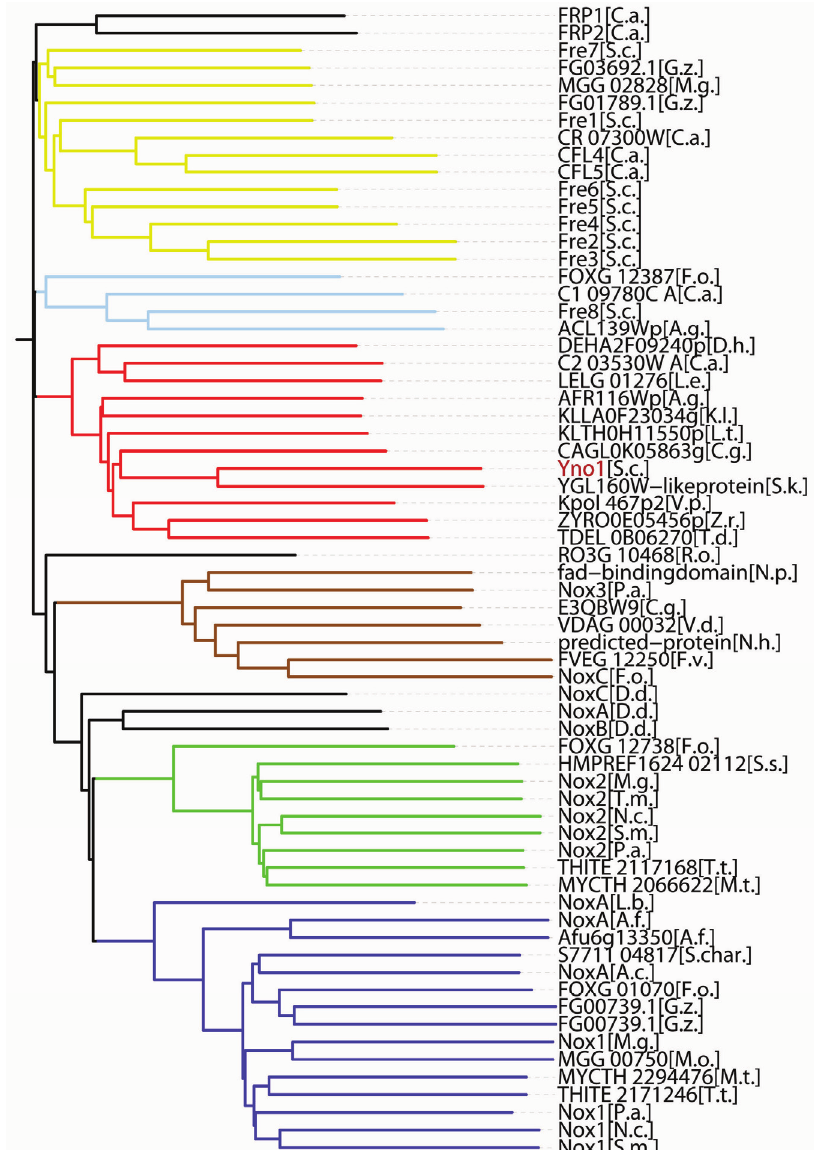
Figure 4. Phylogenetic relationships among the fungal members of the IMR (integral membrane reductase) protein superfamily (see also text for a